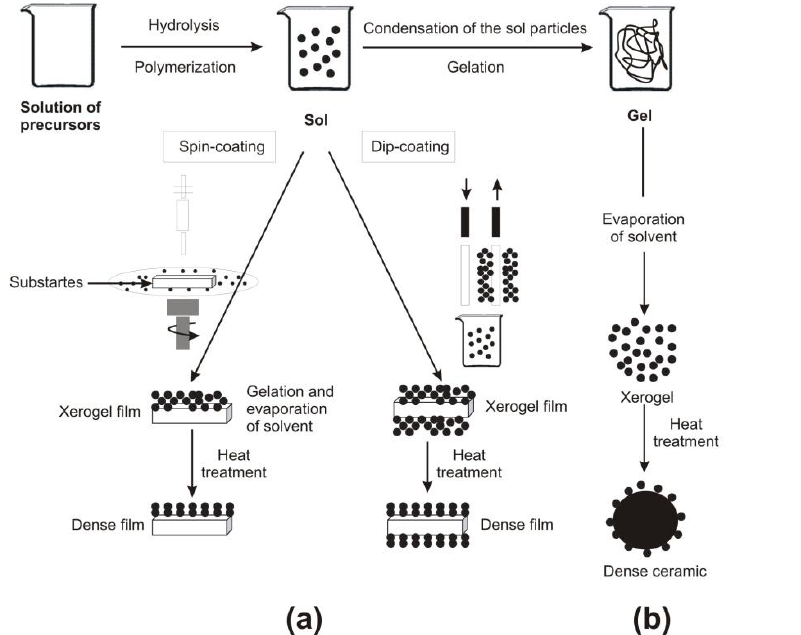
Figure 3. Overview showing two examples of synthesis by the sol-gel method: ( a ) films from a colloidal sol; ( b ) powder from a colloidal sol transformed into a gel (created based on [72] with permission from Elsevier